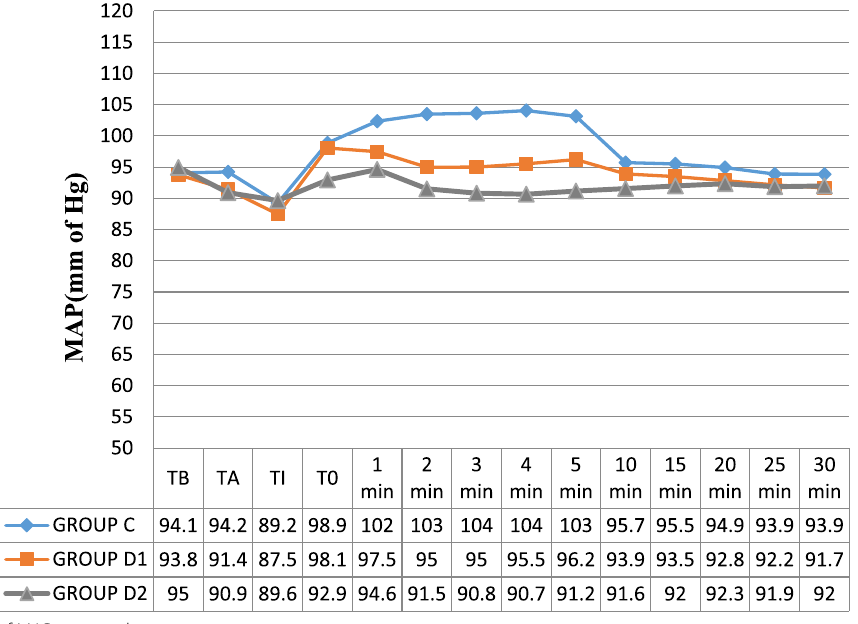
Fig. 5 Comparison of MAP among three groups